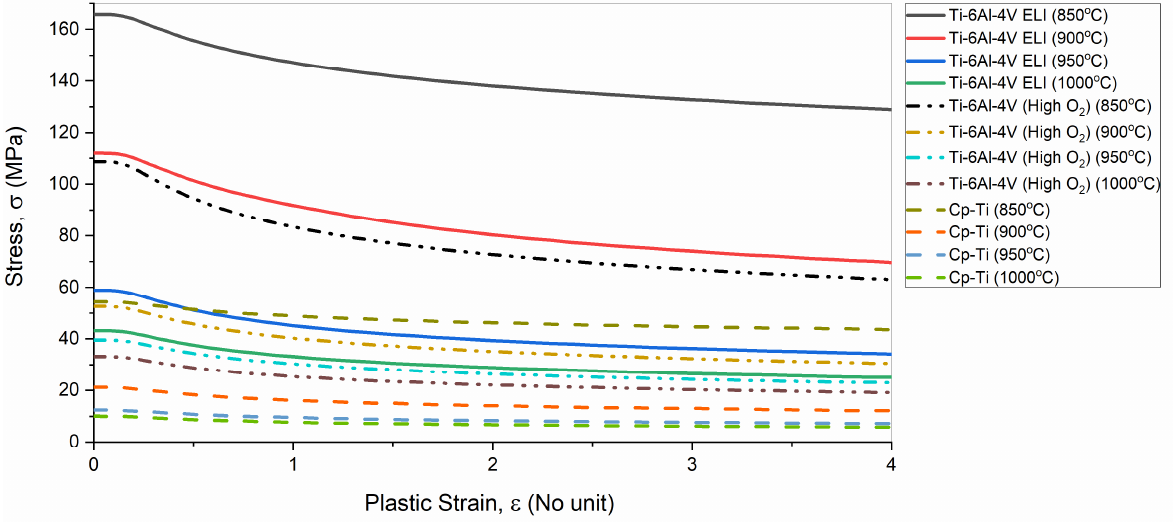
Figure 4. Stress–strain relationship of Ti-6Al-4V ELI, Ti-6Al-4V (high O 2 ), and commercially pure titanium (Cp-Ti) varies with temperature from 850 to 1000 °C.